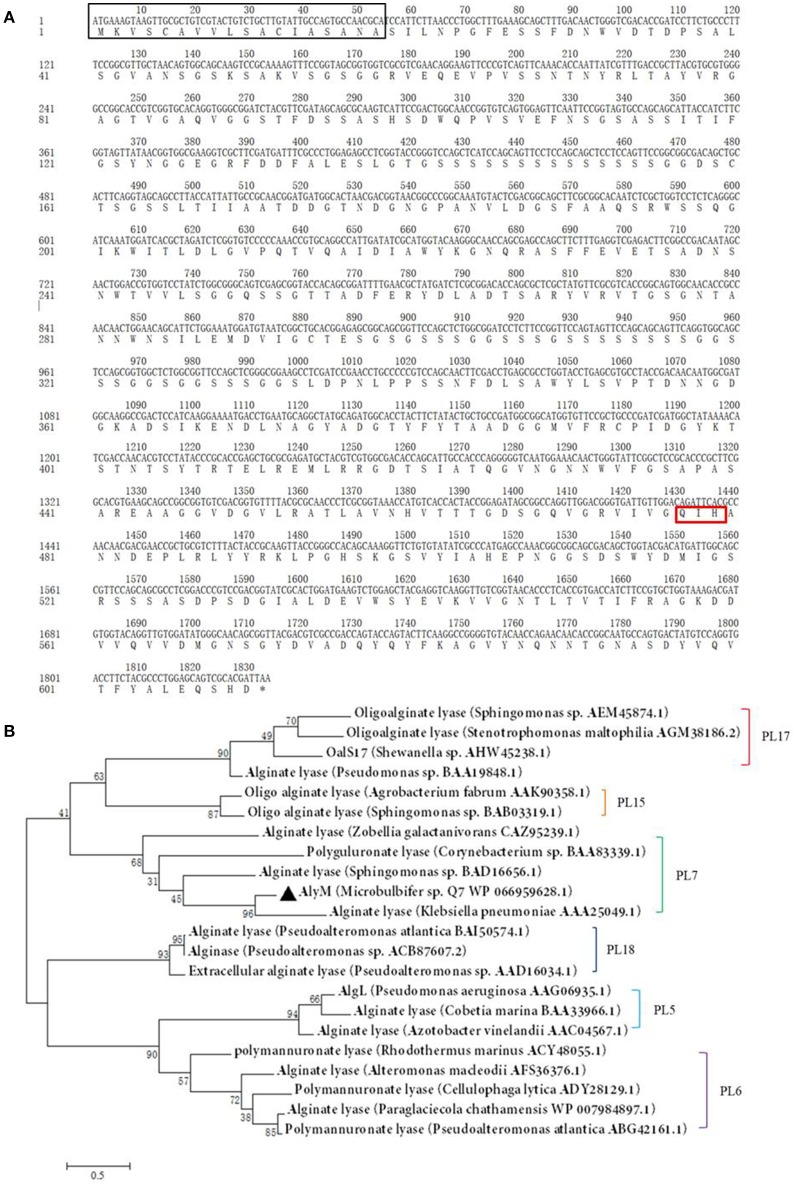
(A) Nucleotide sequences and deduced amino acid sequences of the alginate lyase gene from Microbulbifer sp. Q7. The black box, red box (Q477-I478-H479), and asterisk mark the signal peptide sequence, catalytic residues and stop codon, respectively. The deduced amino acid sequence contains three conserved domains: CBM_4_9 (N17-G82), F5_F8_type_C (D177-M289), and alginate_lyase2 (F344-H609) domains. (B) Phylogenetic analysis of AlyM. This phylogenetic tree was calculated by the method of maximum likelihood. Genbank accession numbers and organism names are given. Branch numbers indicate the bootstrap values in the ML analysis. Arcs with different colors indicate different PL families.